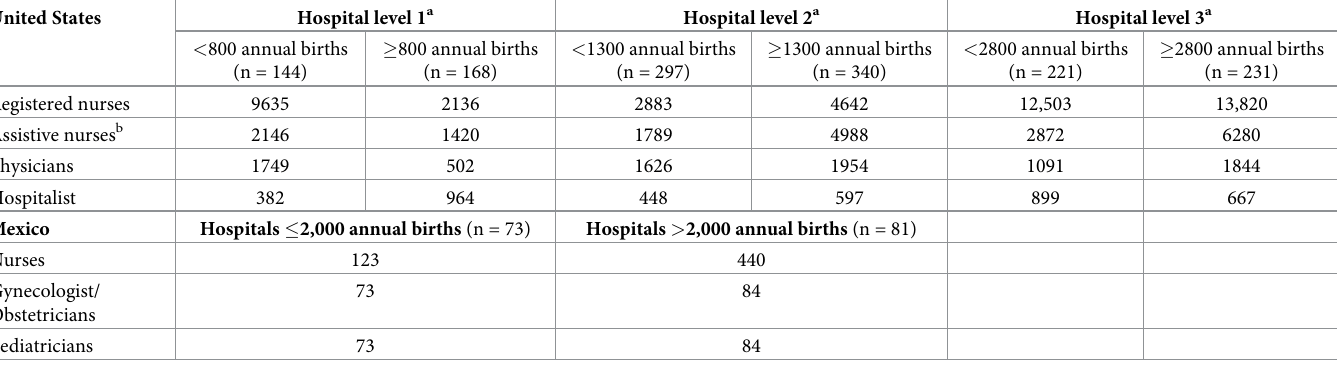
Table 4. Estimates of the number of healthcare providers involved in maternal care by obstetric level and hospital size in the two countries included in the BFHI training